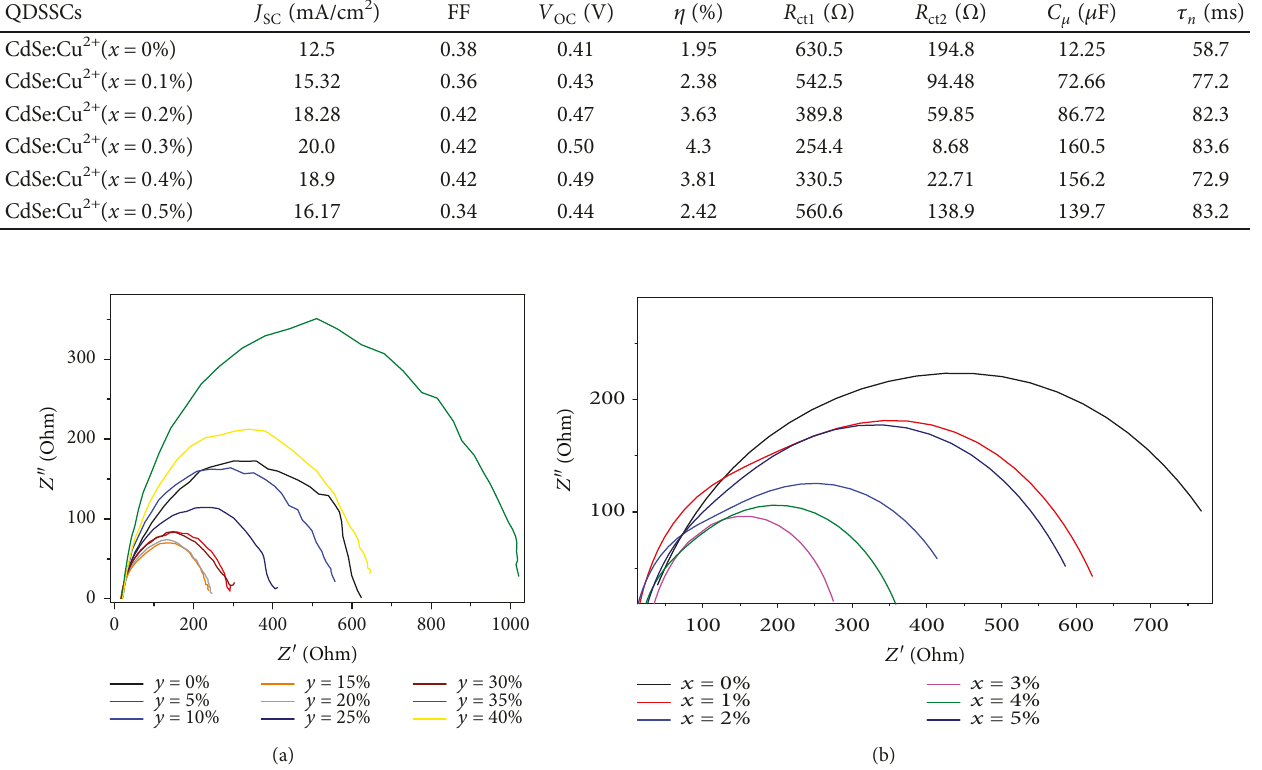
Figure 4: Nyquist curves of QDSSCs. (a) Mn 2+ concentration changing from 0% to 40%. (b) Cu 2+ concentration changing from 0% to